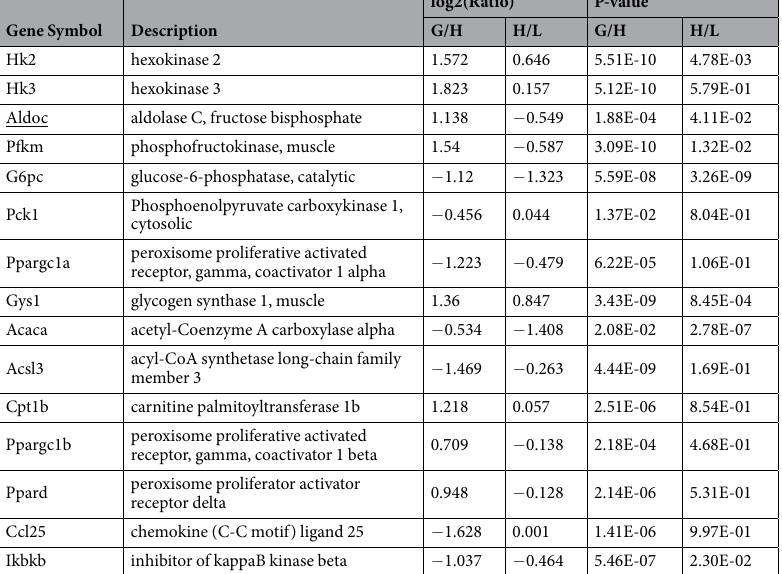
Table 1. cGAMP regulation of liver expression of genes related to metabolic and inflammatory responses. Male C57BL/6 J mice, at 5–6 weeks of age, were fed a high-fat diet (HFD) for 12 weeks and treated with cGAMP (0.2 mg/kg/d) or PBS for the last 4 weeks. Age- and gender-matched mice were fed a low-fat diet (LFD) and treated with PBS. After the feeding/treatment period, liver samples were subjected to microarray analysis. G/H, HFD-cGAMP/HFD-PBS; H/L,